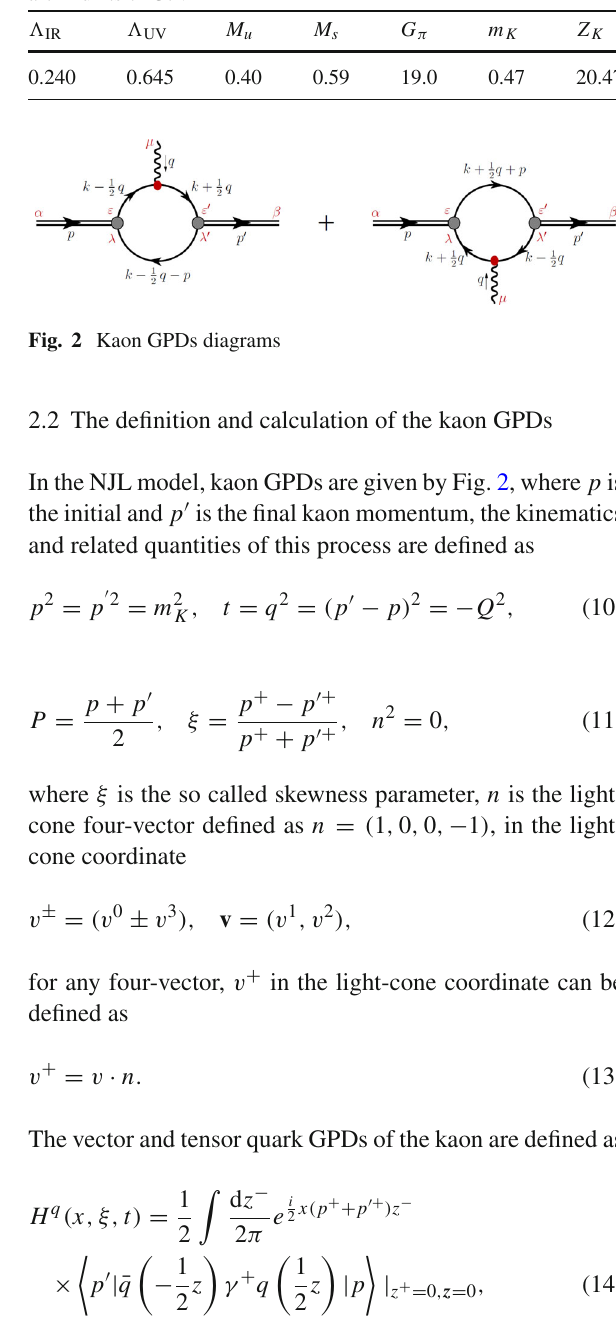
Table 1 Parameter set used in our work. The dressed-quark mass and regularization parameters are in units of GeV, while coupling constant are in units of GeV − 2